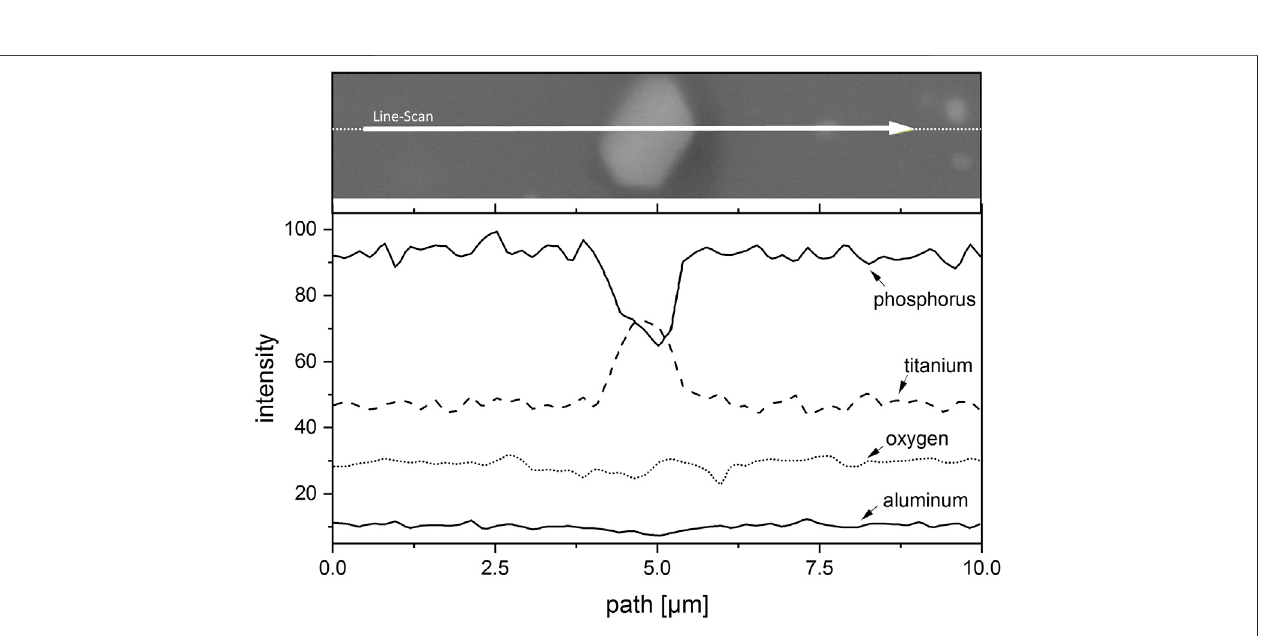
Frontiers in Materials |